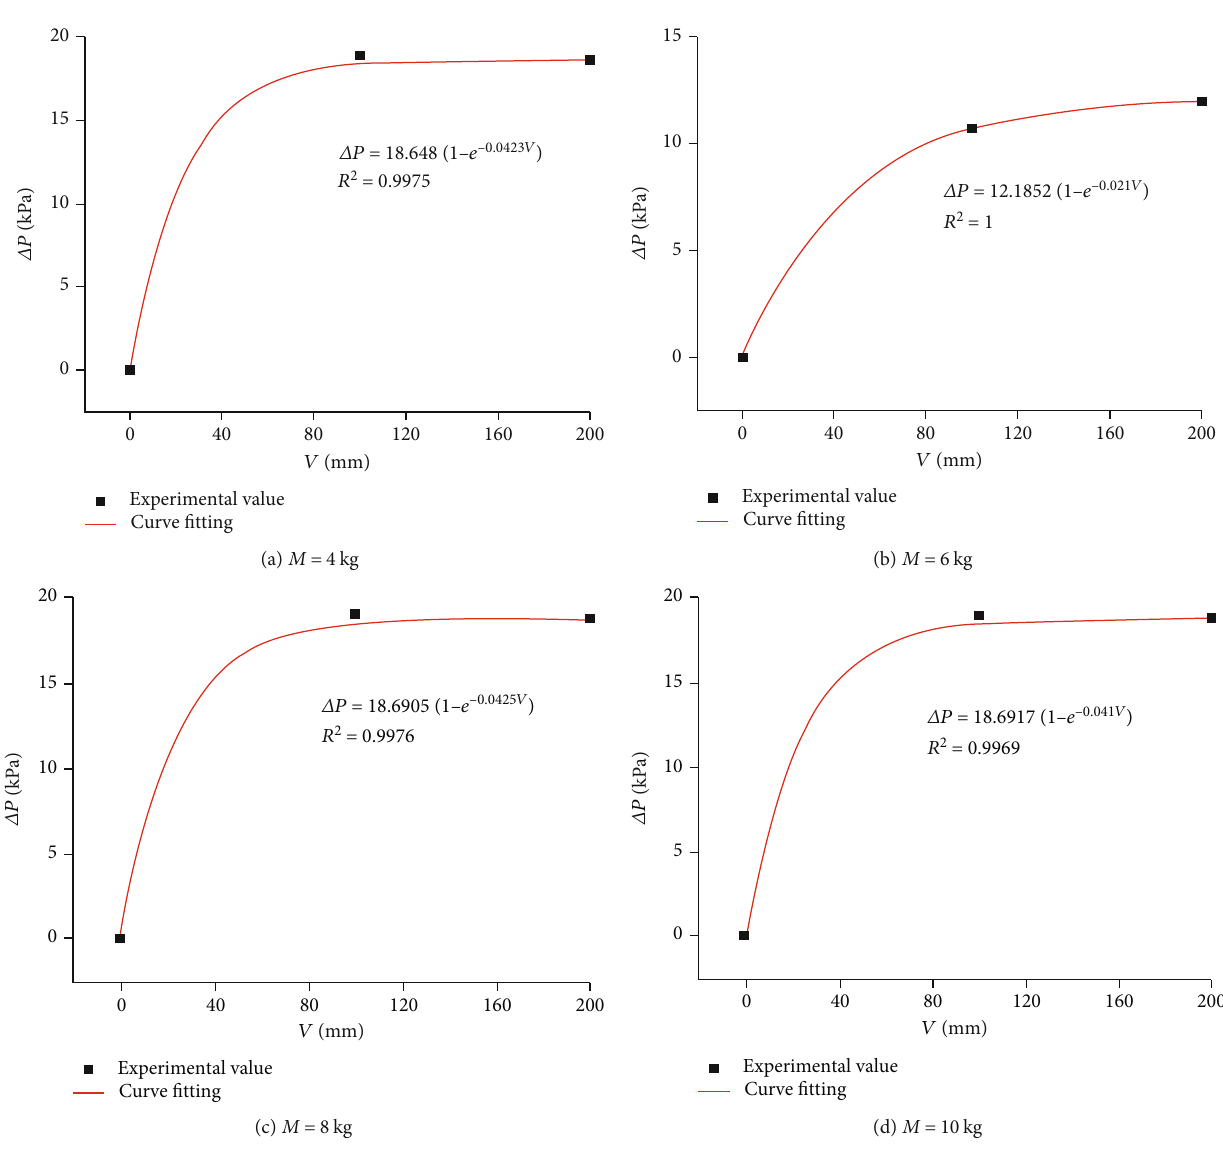
Figure 5: Relationship between pore water di ff erence Δ P and distance V ð F = 2 B Þ